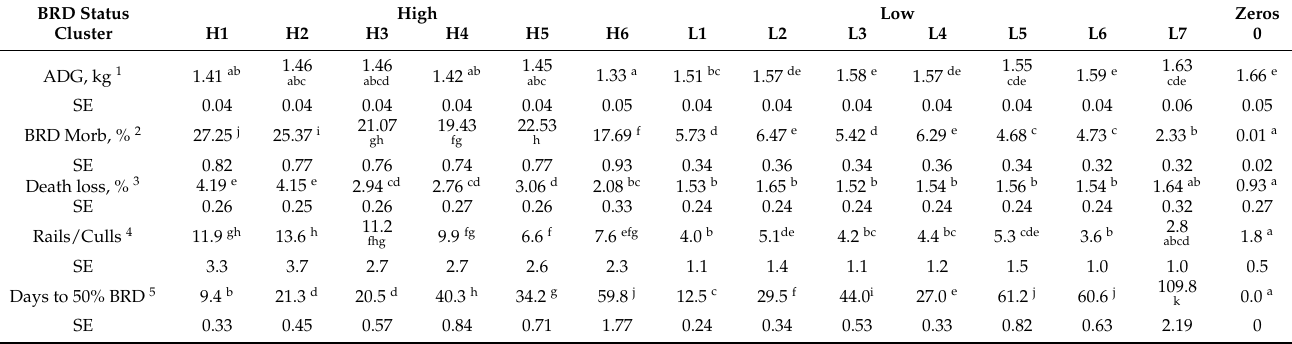
Table 3. Model estimates of performance and health metrics and their association by temporal clustering group using data from 10 US commercial feedlot operations. Feedlot cattle were grouped into HIGH ( ≥ 15%), LOW (>0 to <15%), or ZERO (0%) BRD cohort morbidity for clustering analysis. Differing letters within the same row indicate a statistical difference of p < 0.05 while estimates sharing a letter are not statistically different p >